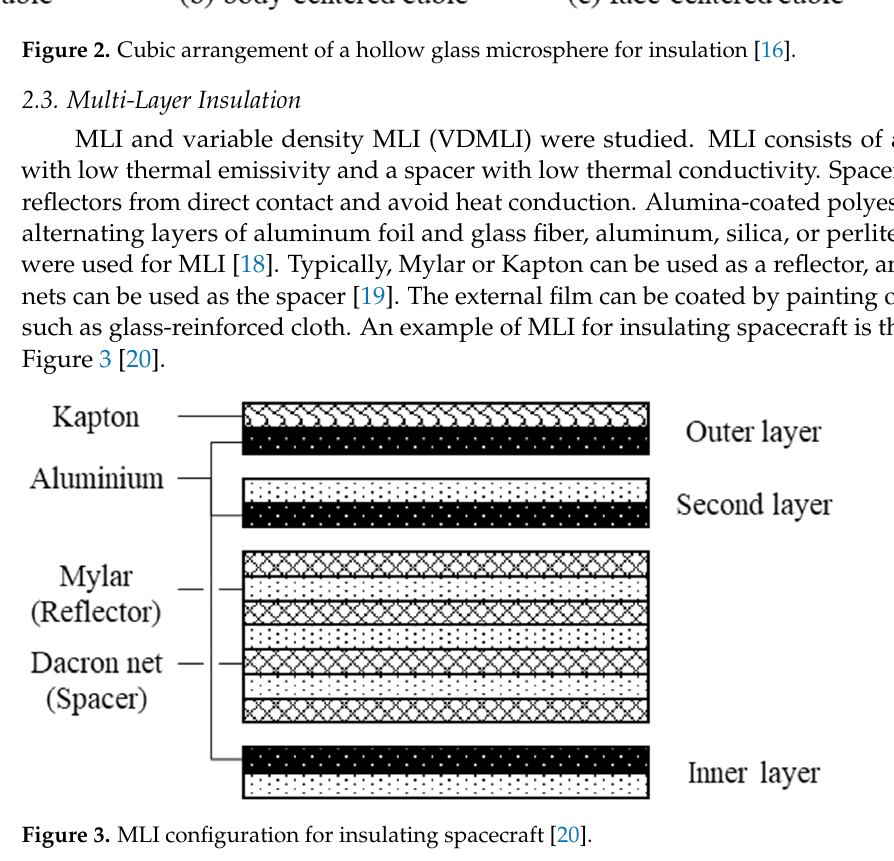
Figure 3. MLI configuration for insulating spacecraft [20].